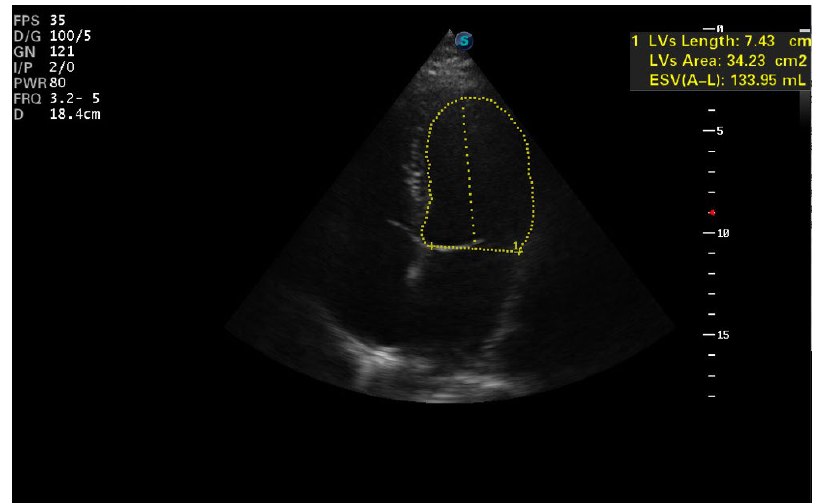
Figure 2. Case 1—TTE left ventricle tele-systolic volume evaluation (yellow dotted line).